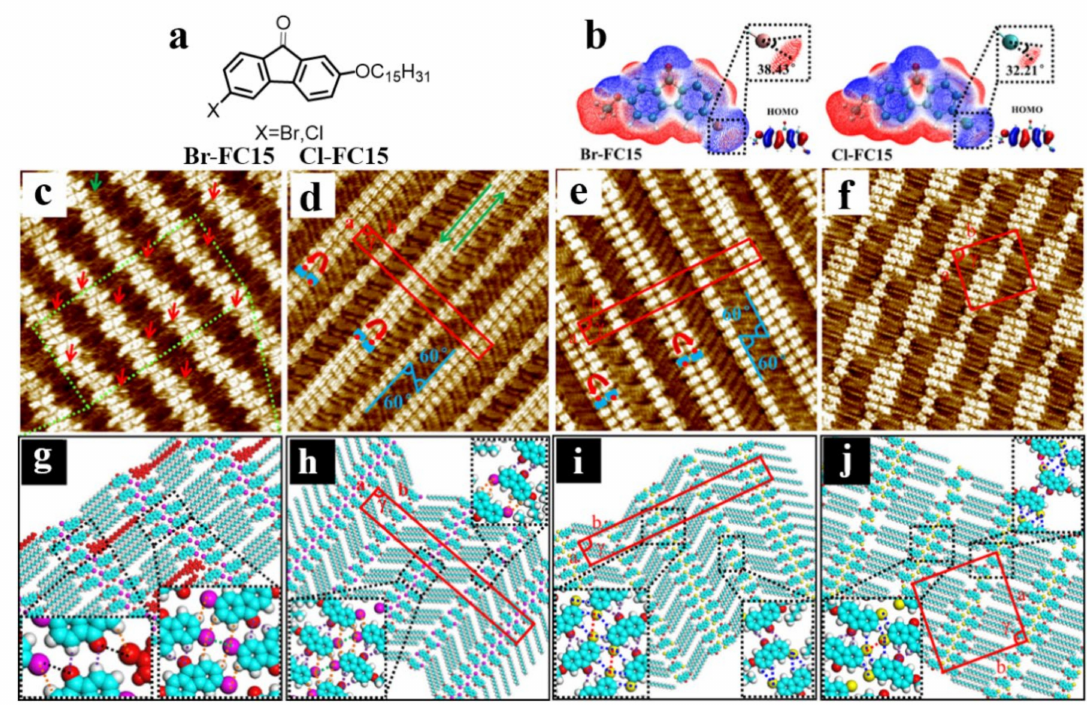
Figure 9. ( a , b ) Chemical structures of Br-FC15 and Cl-ClC15, and their calculated 3D ESP maps. ( c – f ) High-resolution STM images of the self-assembled lamellar and alternate-I patterns (Br-FC15), as well as alternate-II and dumbbell-like patterns (Cl-FC15) at the 1-phenyloctane / HOPG interface. Concentration: ( c ) 3.5 × 10 − 4 M; ( d ) 5.4 × 10 − 5 M; ( e ) 4.5 × 10 − 4 M; ( f ) 6.1 × 10 − 5 M. ( g – j ) Tentative structural models of ( c – f ). Intermolecular interactions are reflected in the enlarged insets.